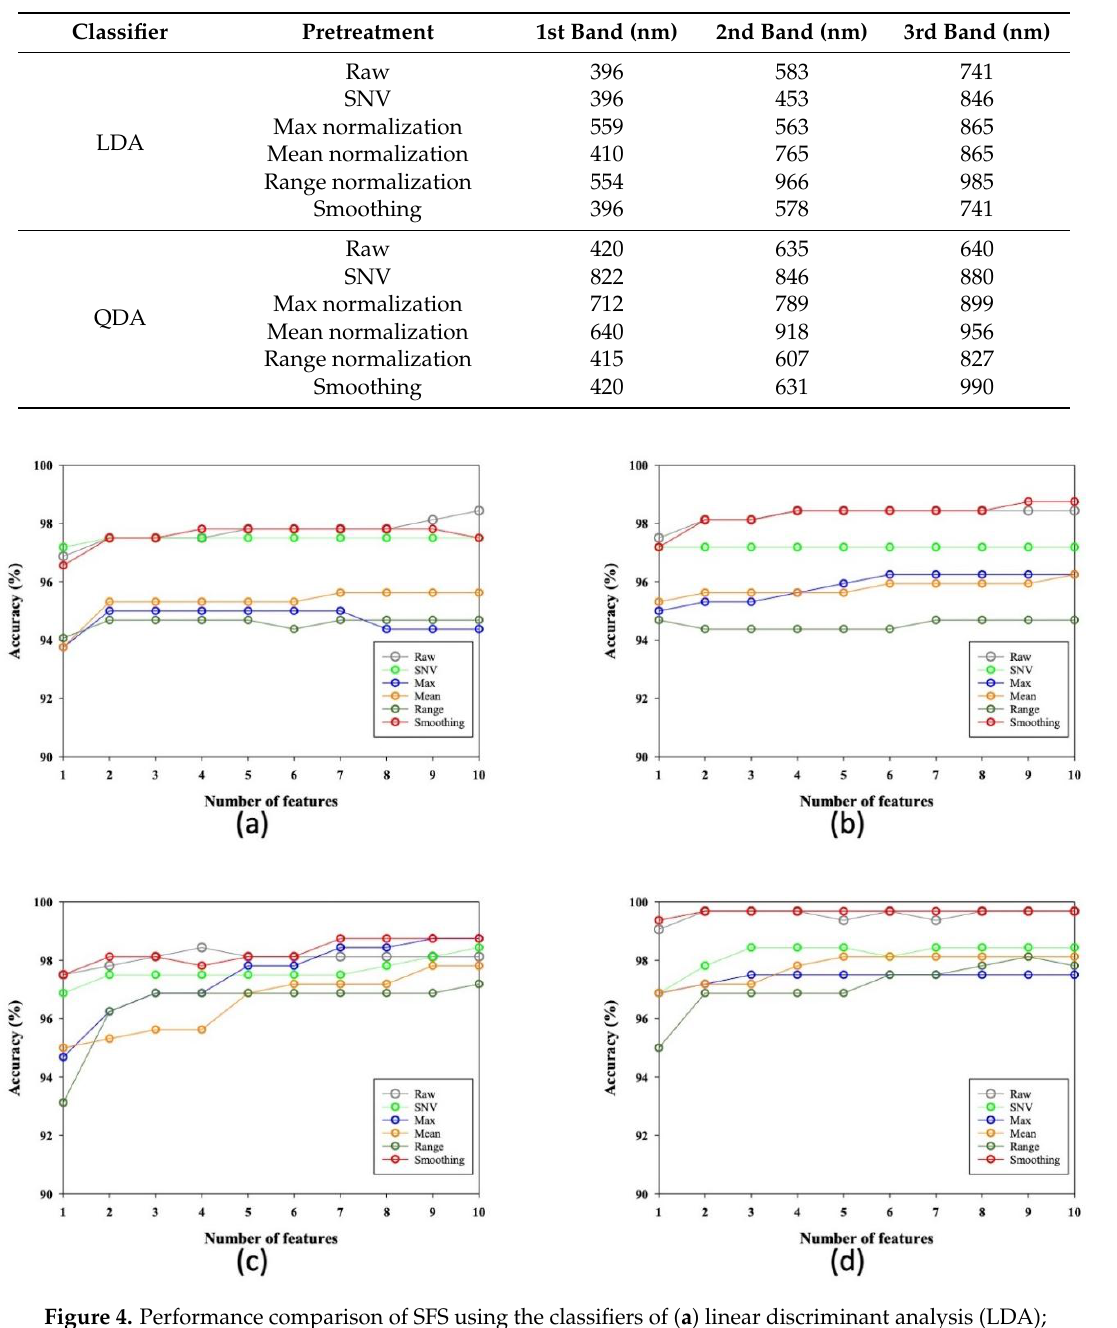
Figure 4. Performance comparison of SFS using the classifiers of ( a ) linear discriminant analysis (LDA); ( b ) quadratic discriminant analysis (QDA); ( c ) support vector machine (SVM) and ( d ) SVM with radial basis function (RBF) kernel, with different data preprocessing methods for two-class classification.